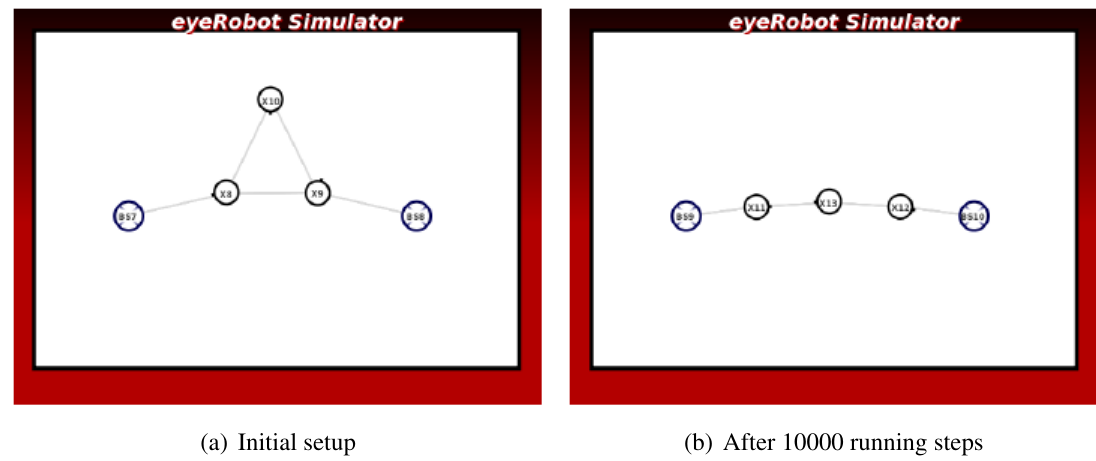
Figure 10. The experiment of Triangle scenario.